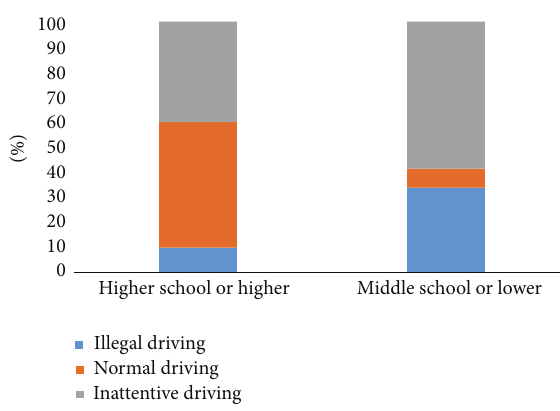
Figure 5: Breakdown of precrash behaviors for e-bike riders with different educational background.